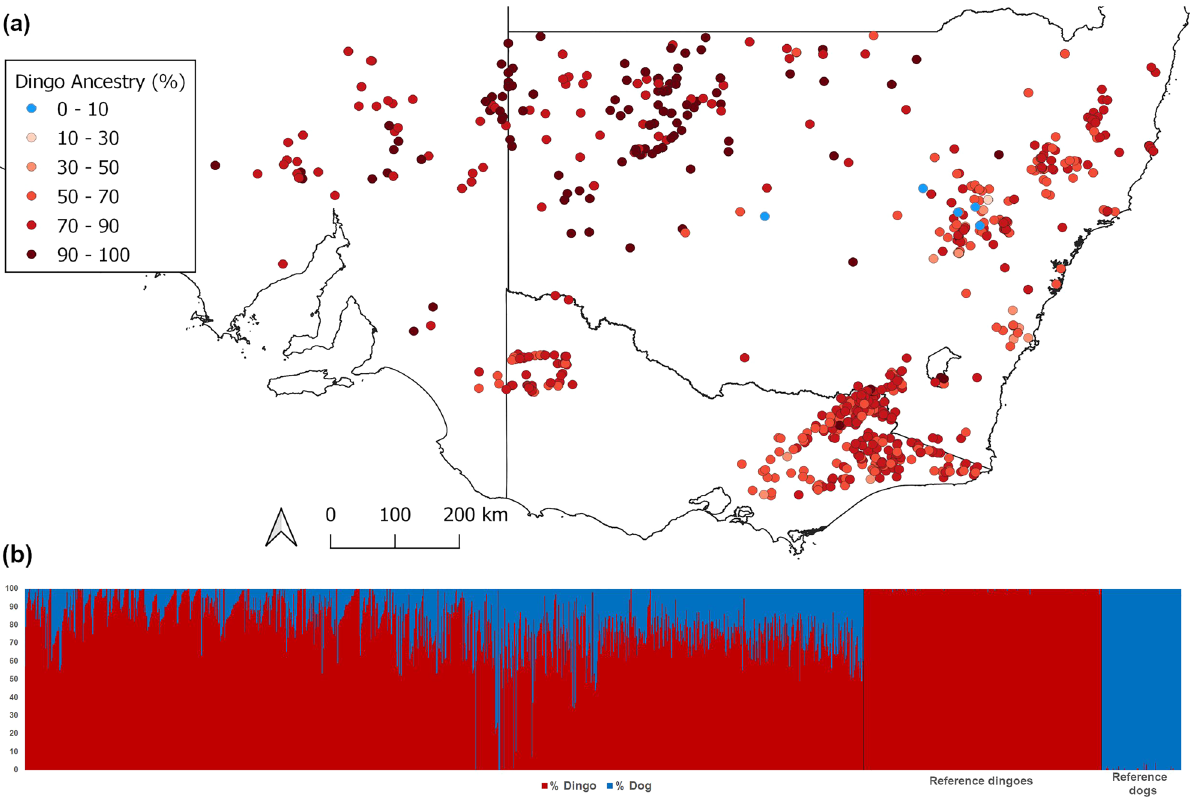
Figure 1. Spatial distribution of free-ranging dogs in south eastern Australia showing higher dingo ancestry in the north west and more hybrids in the south and east ( a ) map of individuals’ dingo ancestry percentage. ( b ) Bar plot of Structure results, sorted by latitude (west to east) then by longitude (north to south) for test individuals. Reference individuals are unsorted. Each line represents the percentage of one individual’s ancestry assigned to either the dingo or domestic dog